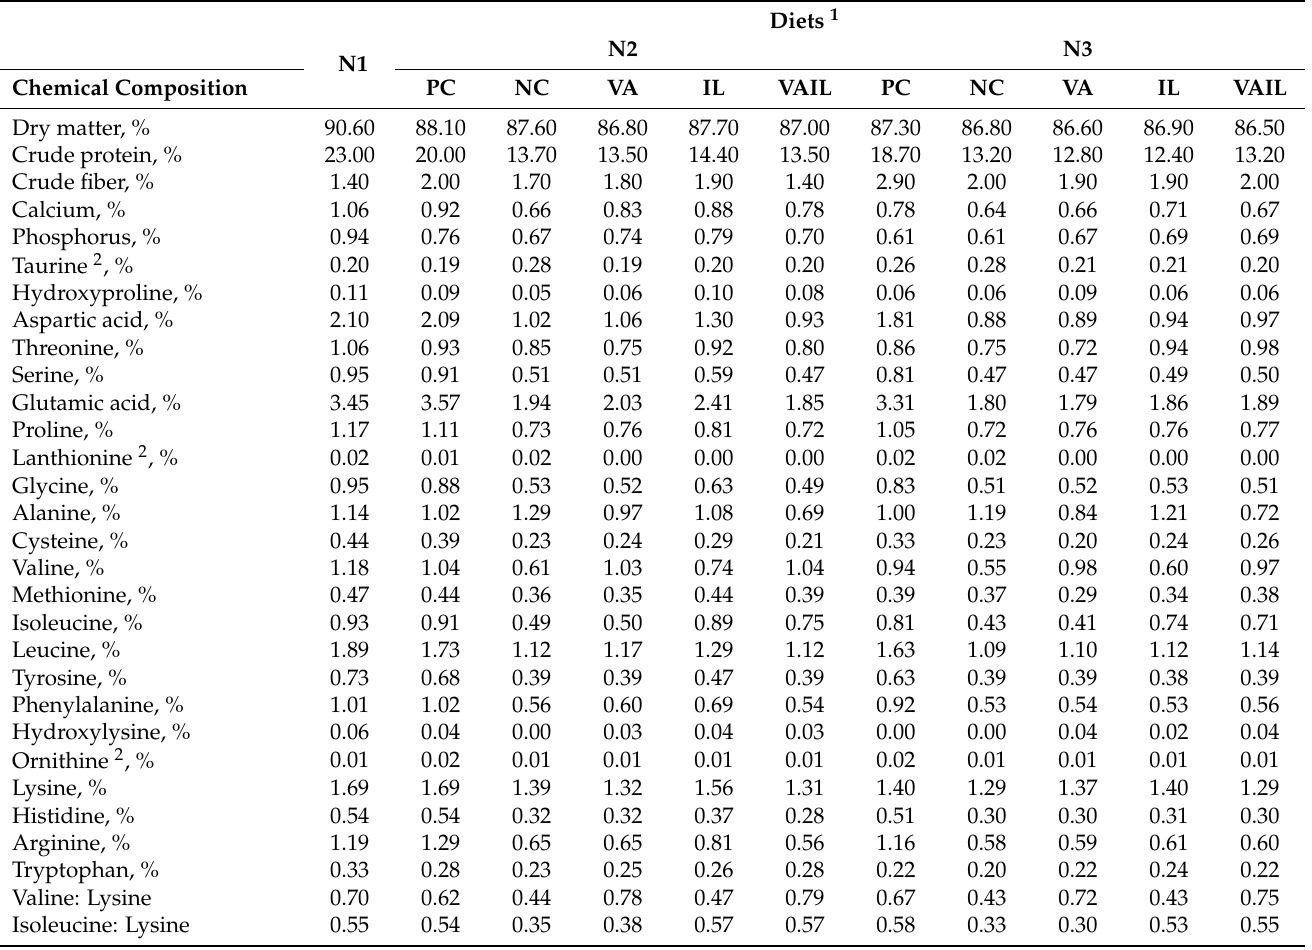
Table 5. Analyzed chemical composition of experimental diets (as-fed